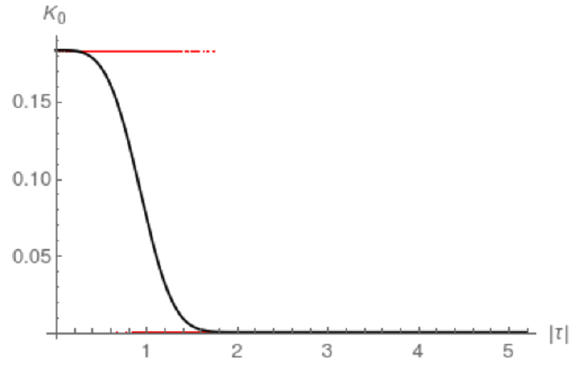
p 2, in 4d de Sitter. The black